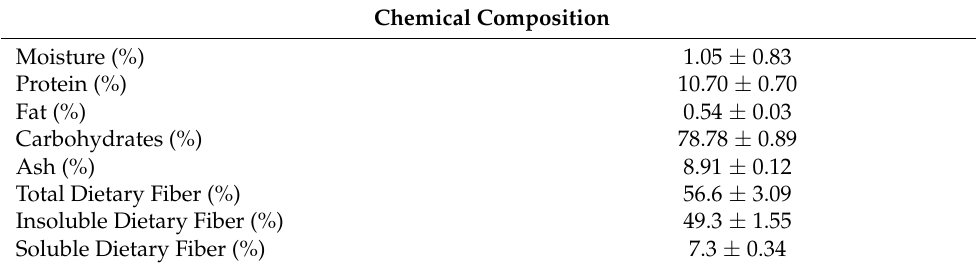
Table 2. Chemical composition of the mushroom protein by-product.